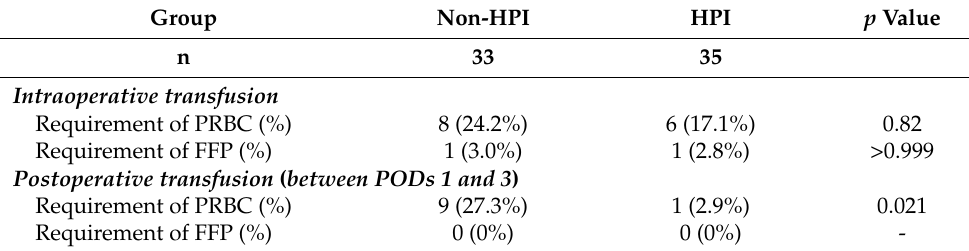
Table 5. Blood transfusion